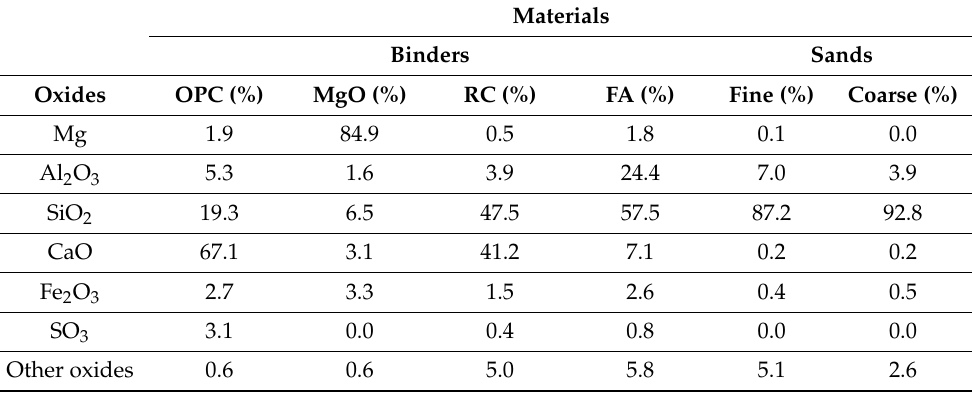
Table 1. Chemical composition of the materials (XRF